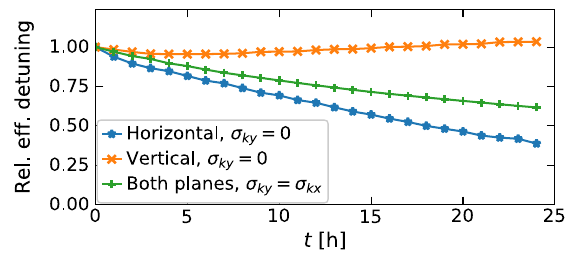
FIG. 7. Evolution of the relative effective detuning strengths, corresponding to the distribution evolutions in Figs. 5 and 6.